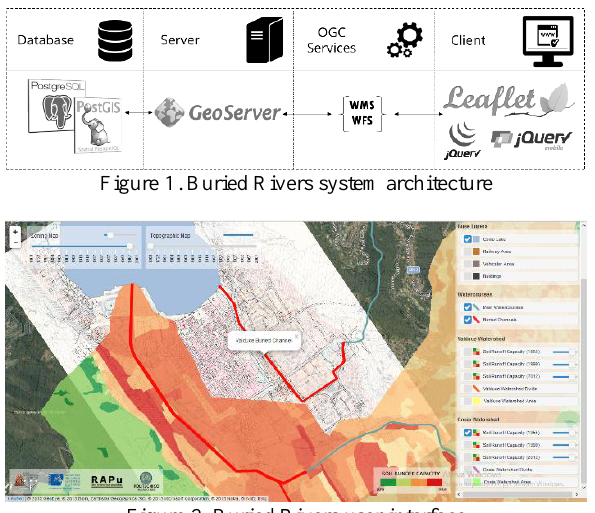
Figure 2. Buried Rivers user